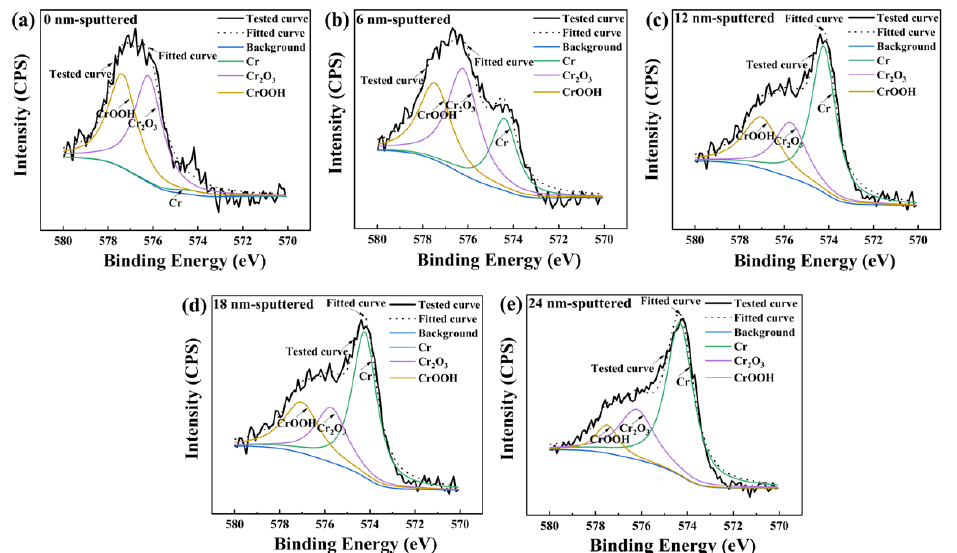
Figure 8. XPS depth analysis of Cr 2p 3/2 at ( a ) 0 nm, ( b ) 6 nm, ( c ) 12 nm, ( d ) 18 nm, and ( e ) 24 nm in the passive film of the SNC rebar.